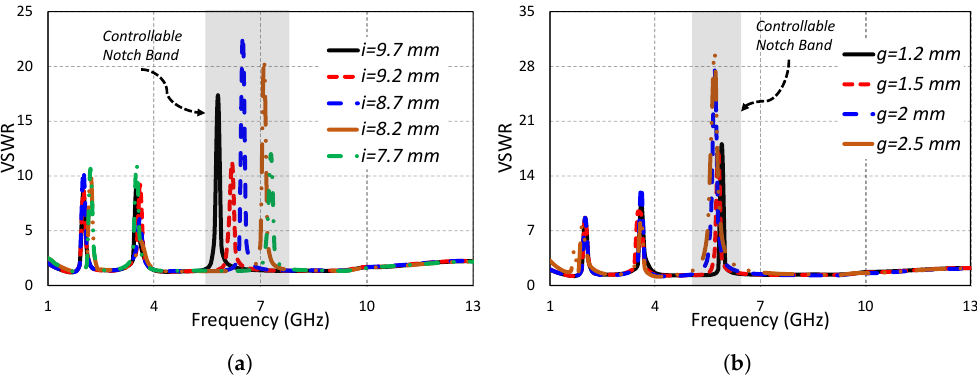
Figure 8. Independently-controllable higher notch band by varying ( a ) i and ( b ) g